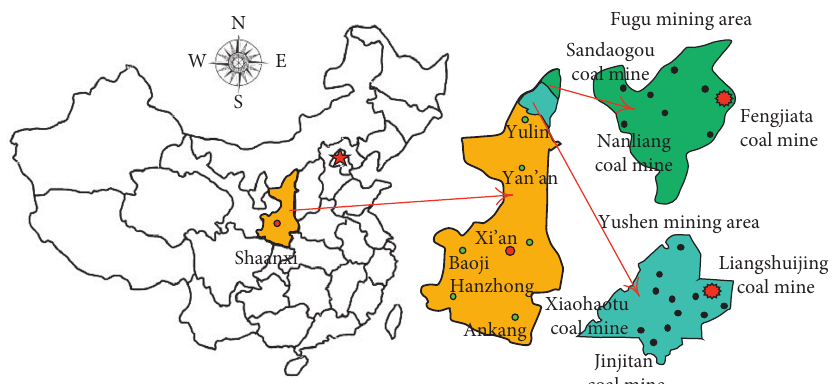
Figure 6: Geographical locations of the two mines.